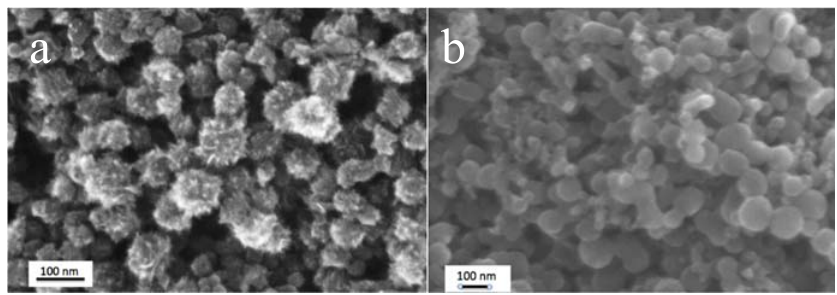
Figure 7. SEM images of dahlia ( a ) and bud ( b ) morphologies.